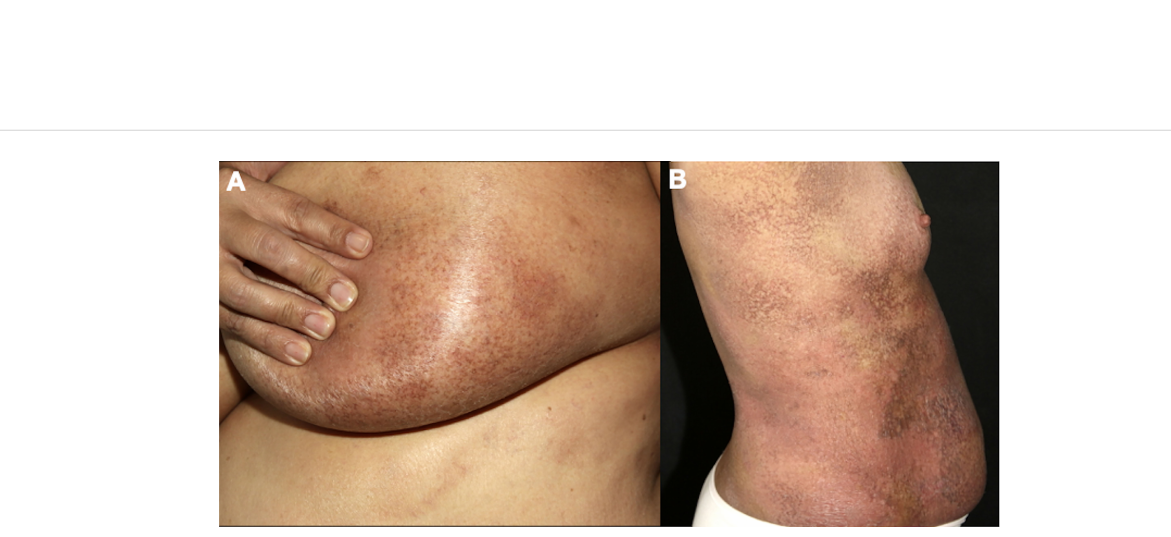
FIGURE 6 Poikilodermatous MF with localized (A) and generalized lesions (B) .